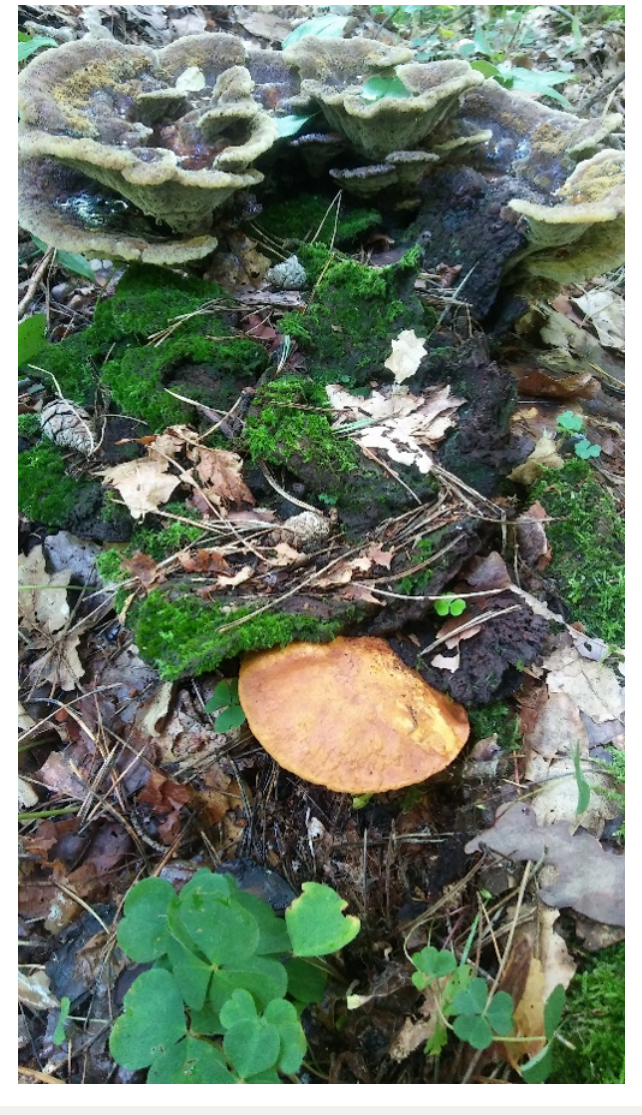
Figure 3 Basidioma of Buchwaldoboletus lignicola adjacent to sporocarps of Phaeolus schweinitzii from Kampinos National Park; August 12, 2021. Photography by A.